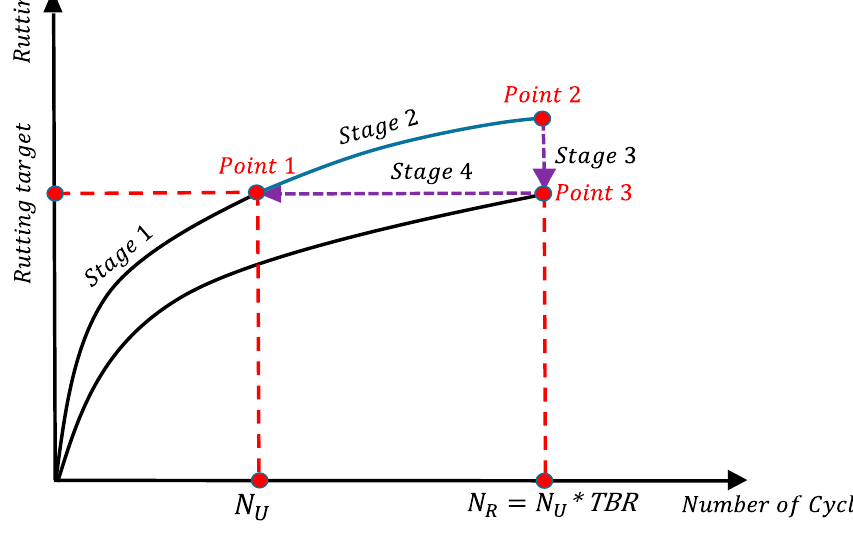
Figure 6. Different stages of structural benefits calculations.